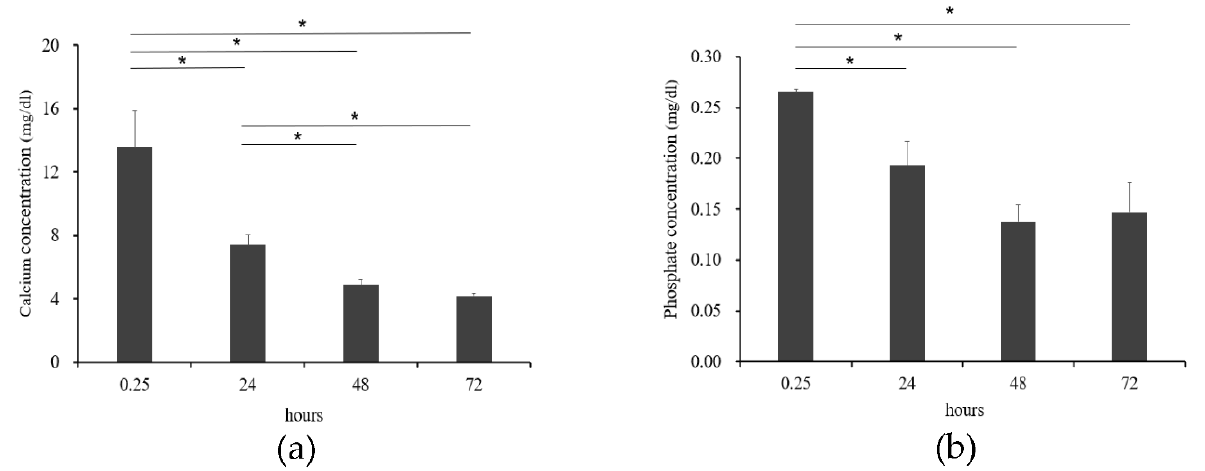
Figure 3. Changes in Ca ( a ) and P ( b ) concentration in the supernatant of supersaturated calcium phosphate solution (n = 4, * p < 0.05).